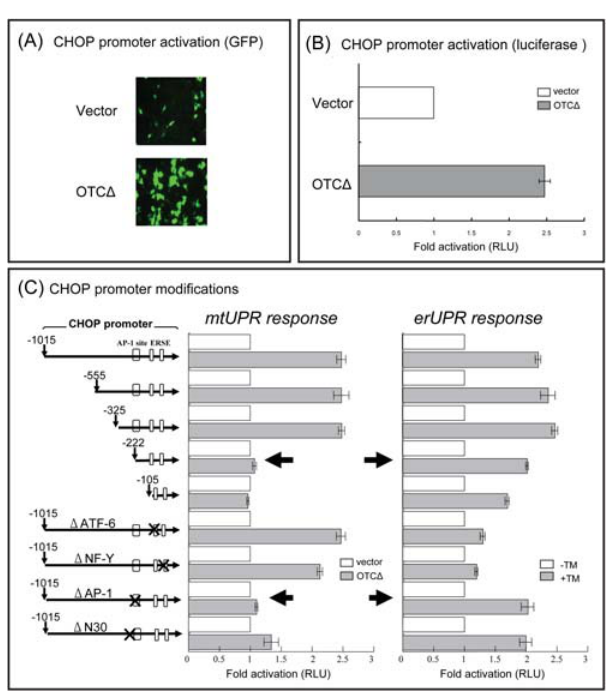
Figure 1. Identification of mtUPR response element in chop promoter. (A) and (B): Chop is transcriptionally activated by mtUPR. COS-7 cells co-transfected with empty vector or OTC D were assayed for GFP (A) or luciferase (B) 32 h after transfection. (C): identification of an mtUPR element in the chop promoter was determined by a deletion analysis as shown. Deletions are shown as distance (bp) from the chop transcription start site. The fold activation of the promoter constructs in cells transfected with OTC D (slash bars) are compared with vector controls (open bars) as relative luciferase (RLU) activity. RLU activity of the promoter constructs in cells treated with or without 2 m g/ml tunicamycin (TM), to produce erUPR is shown as a control. Data represents the mean 6 SEM from experiments performed in